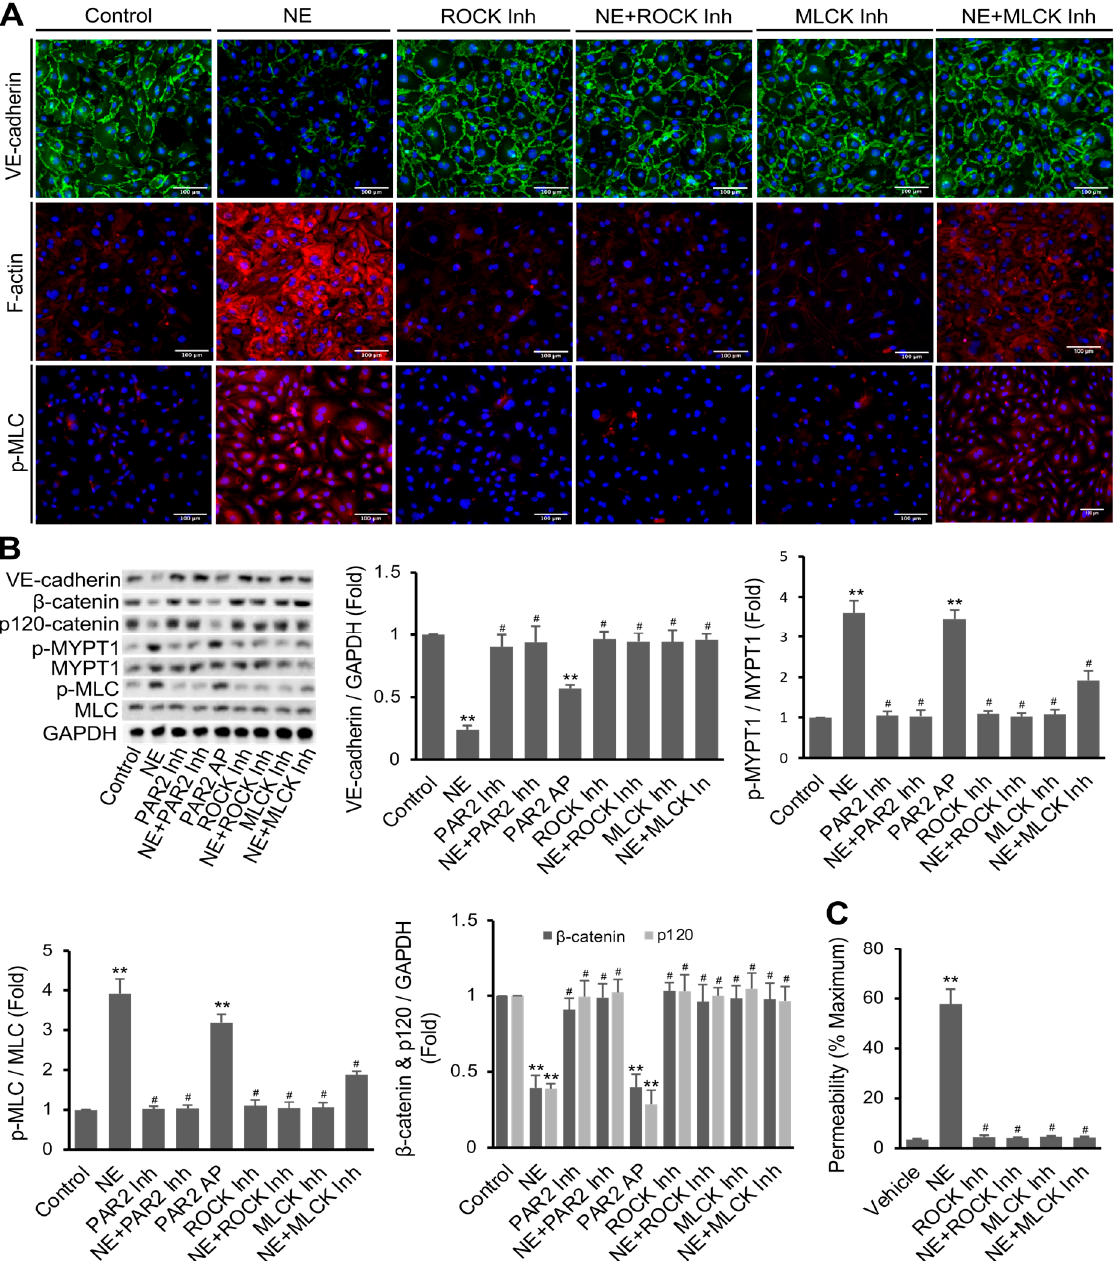
Figure 3. Regulation of NE’s effects by PAR2 downstream signaling components ROCK and MLCK. ( A ) hECs were treated with ROCK inhibitor (Y27632, 5 µ M) and MLCK inhibitor (peptide 18, 5 µ M) with or without NE (20 nM) for 16 h. Images (20 × ) were taken after immunofluorescence staining of VE-cadherin (green) and p-MLC (pSer19, red), F-actin staining with phalloidin (red), and nuclei staining with DAPI (blue). Images are representatives of three independent experiments (scale bar, 100 µ m). ( B ) Western blot analysis confirming the changes of VE-cadherin, β -catenin, p120-catenin, p- MYPT1 (pThr853), and p-MLC (pSer19) in hECs. GAPDH was used as an internal control for protein loading. ( C ) Confluent hECs on transwells (with 0.4 µ m pore size) were treated with or without NE (20 nM) in the presence or absence of ROCK or MLCK inhibitor for 16 h. Lucifer Yellow was used to measure cell permeability, and the results were expressed as percentage of control (transwells without cells). All data are expressed as mean ± SD of three independent experiments. ** p < 0.01 vs. vehicle control group, # p < 0.05 vs. NE group. NE: neutrophil elastase, ROCK Inh: ROCK inhibitor, MLCK Inh: MLCK inhibitor. See also Figure